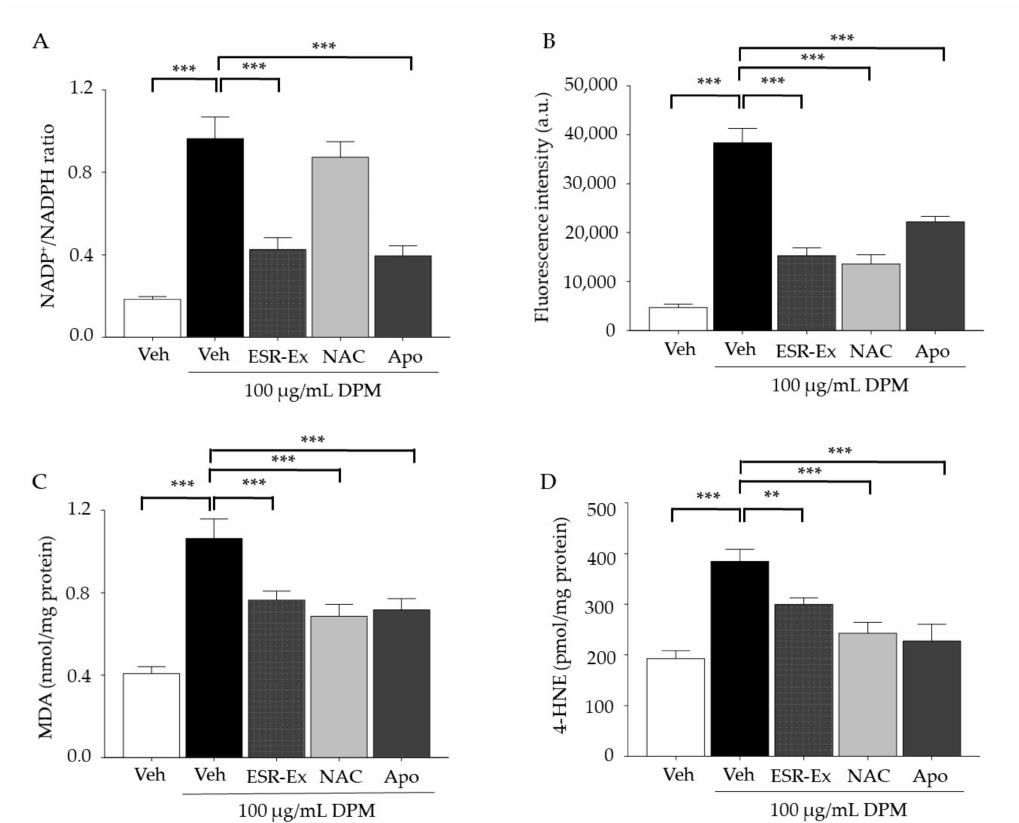
Figure 2. ESR-Ex suppresses both NOX activation and increases in ROS production in KC treated with DPM. KC were incubated with or without ESR-Ex (100 µ g/mL), NAC (1 mM), Apo (100 µ M) or vehicle for 30 min, and then further cultured with 100 µ g/mL of DPM for 24 h. Measuring the ratio of NADP+ to NADPH with LC-ESI-MS/MS (API 3200 QTRAP mass, AB/SCIEX) by multiple reaction monitoring mode (MRM) ( A ). Intercellular ROS production was determined by fluorospectrophotometer ( B ). Malondialdehyde (MDA) ( C ) and 4-hydroxynonenal (4-HNE) ( D ) were determined by LC-ESI-MS/MS after dansyl hydrazine derivatization. All values are mean ± SD ( n = 3). *** p < 0.001 or ** p < 0.01 vs. indicated group. See details in Materials and Methods